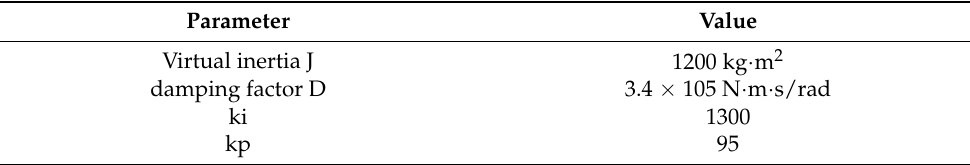
Table 3. The control parameters of the VSC station.